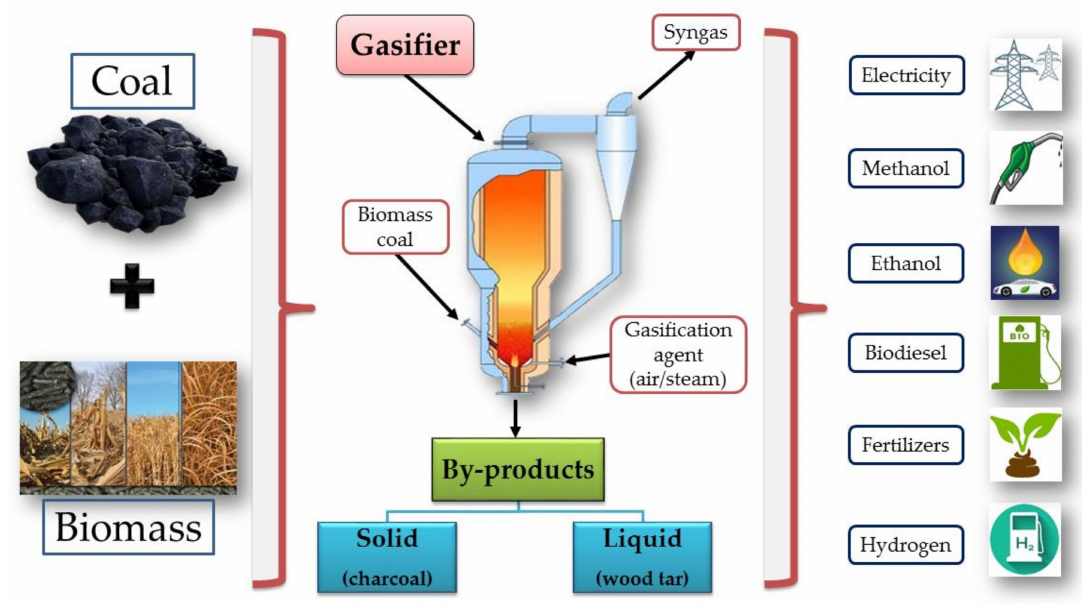
Figure 1. Schematic diagram of gasification